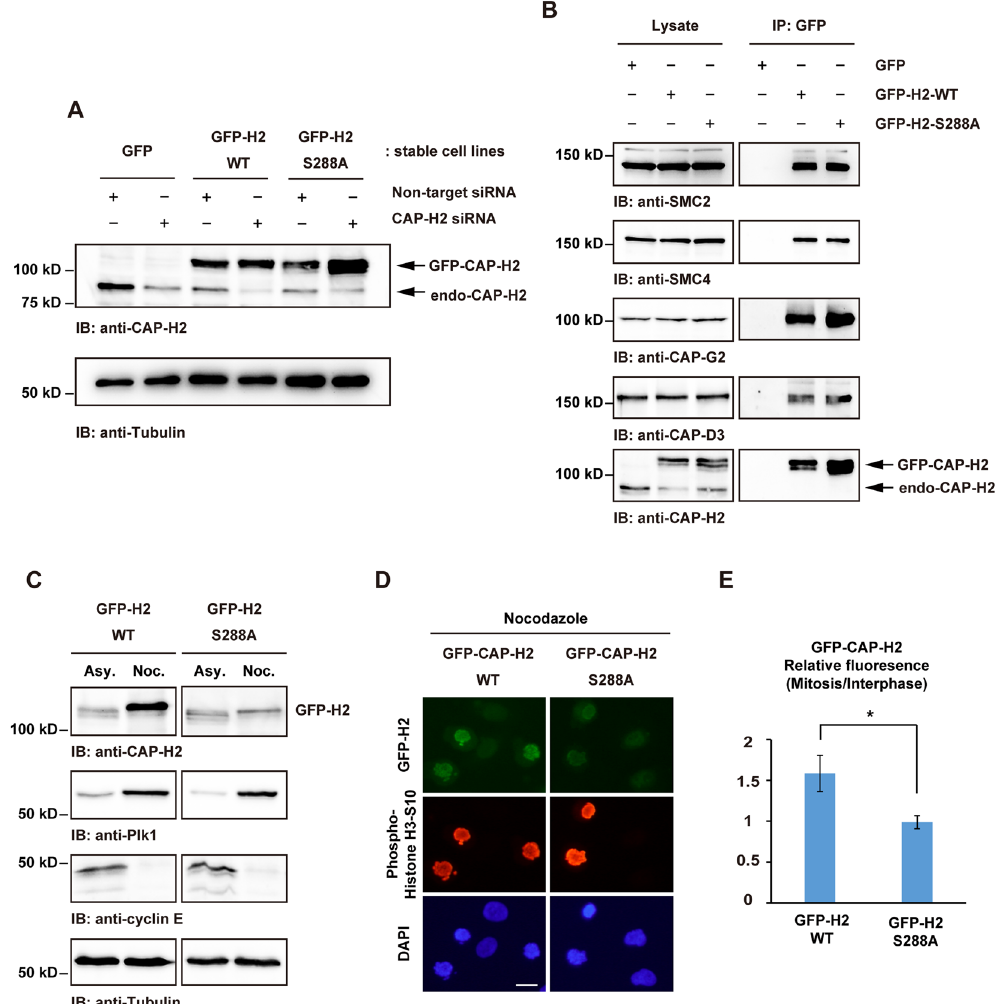
Figure 5. S288 phosphorylation regulates the fluctuation of CAP-H2 in mitosis. ( A ) HeLa cells stably expressing GFP (GFP), GFP-CAP-H2-WT (WT), or GFP-CAP-H2-S288A (S288A) were transfected with non-target siRNA or CAP-H2 siRNA. Lysates were immunoblotted with indicated antibodies. ( B ) Lysates from GFP, WT, or S288A cell lines were immunoprecipitated with anti-GFP and were immunoblotted with the indicated antibodies. ( C ) WT or S288A stable cell lines were transfected with non-target siRNA or CAP-H2 siRNA followed by nocodazole treatment. Cell lysates were immunoblotted with the indicated antibodies. ( D ) WT or S288A stable cell lines were treated with nocodazole and then fixed. Fixed cells were stained with anti- phospho-histone-H3 Ser10. DNA was stained by DAPI. Scale bar, 20 μ m. ( E ) The mean fluorescence of mitotic GFP-CAP-H2 was normalized by fluorescence of interphase GFP-CAP-H2 in WT or S288A stable cell lines. n > 30 mitotic cells per indicated condition were analyzed. Data represent mean ± SD from three independent experiments. Statistical analysis was performed with the Student’s t test ( * P <